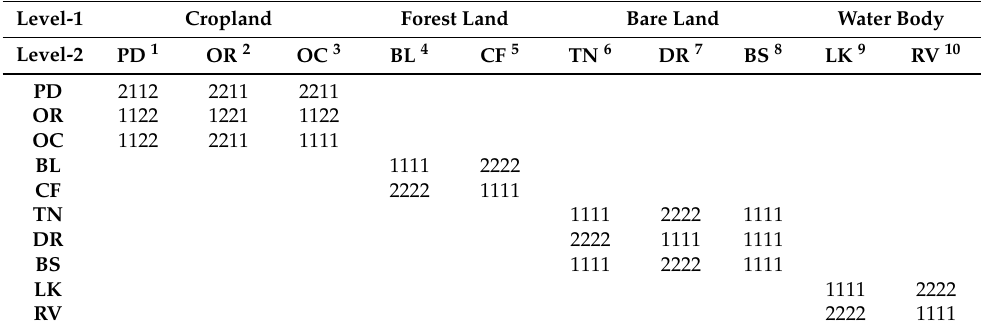
Table 3. Four-digit codes for Level-2